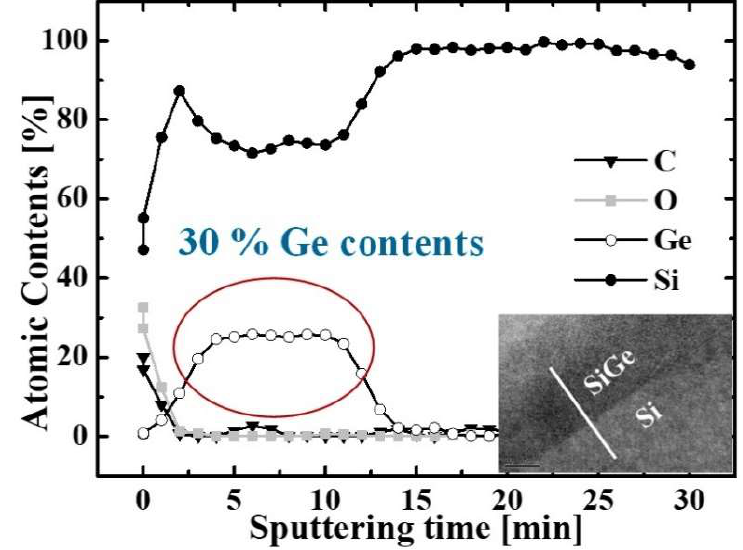
Figure 2. Fabrication process flow of the proposed TFETs. The flow graph summarize all the fabrication process briefly.